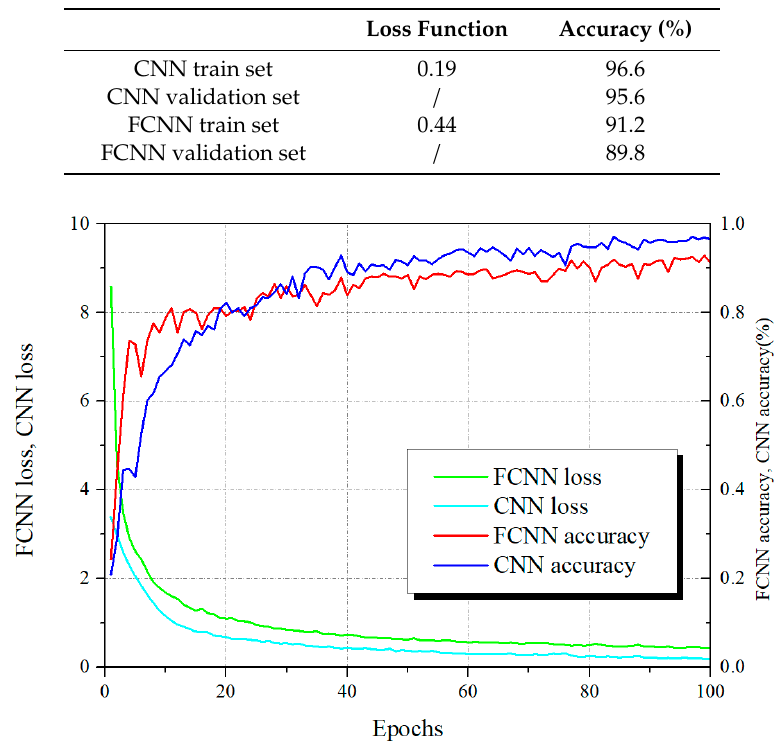
Figure 11. The changes in the accuracy and loss function curve for FCNN and CNN on training set as the number of iterations increases. Table 6. Model prediction accuracy.